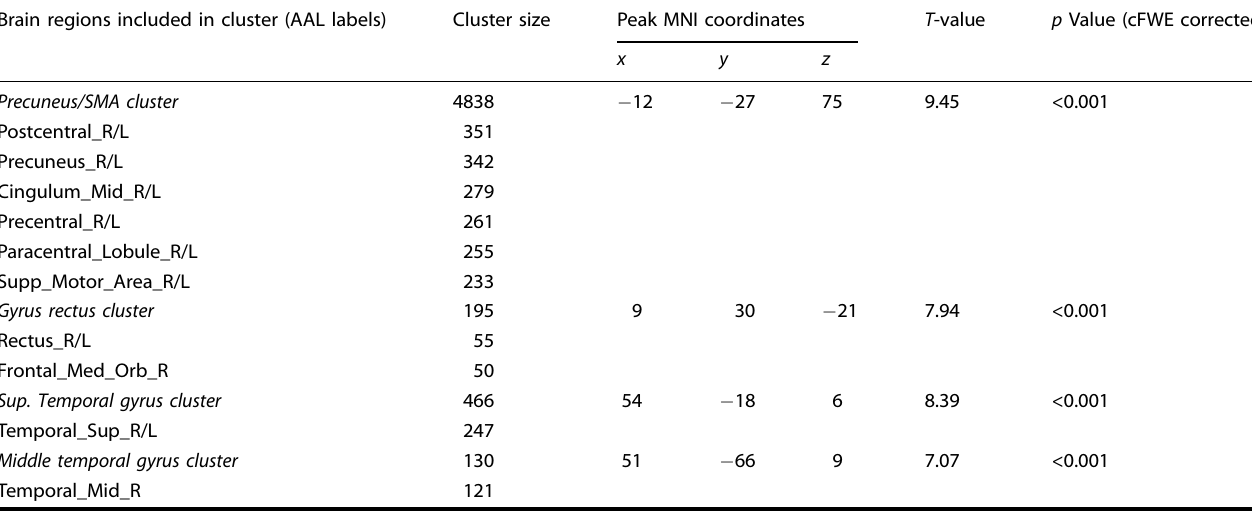
Table 5. Functional connectivity of the medial superior parietal lobule cluster to other brain areas in the FEP group ( n = 38). Brain regions included in cluster (AAL